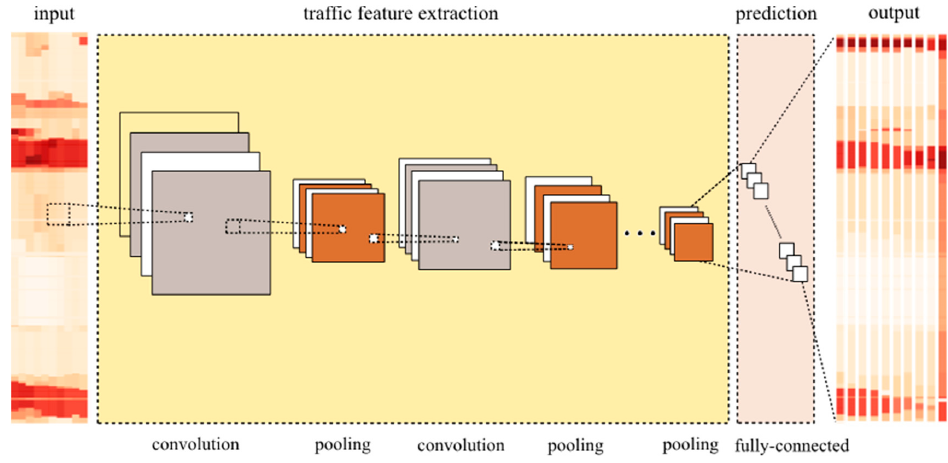
Figure 2. Deep learning architecture of CNN in the context of transportation.